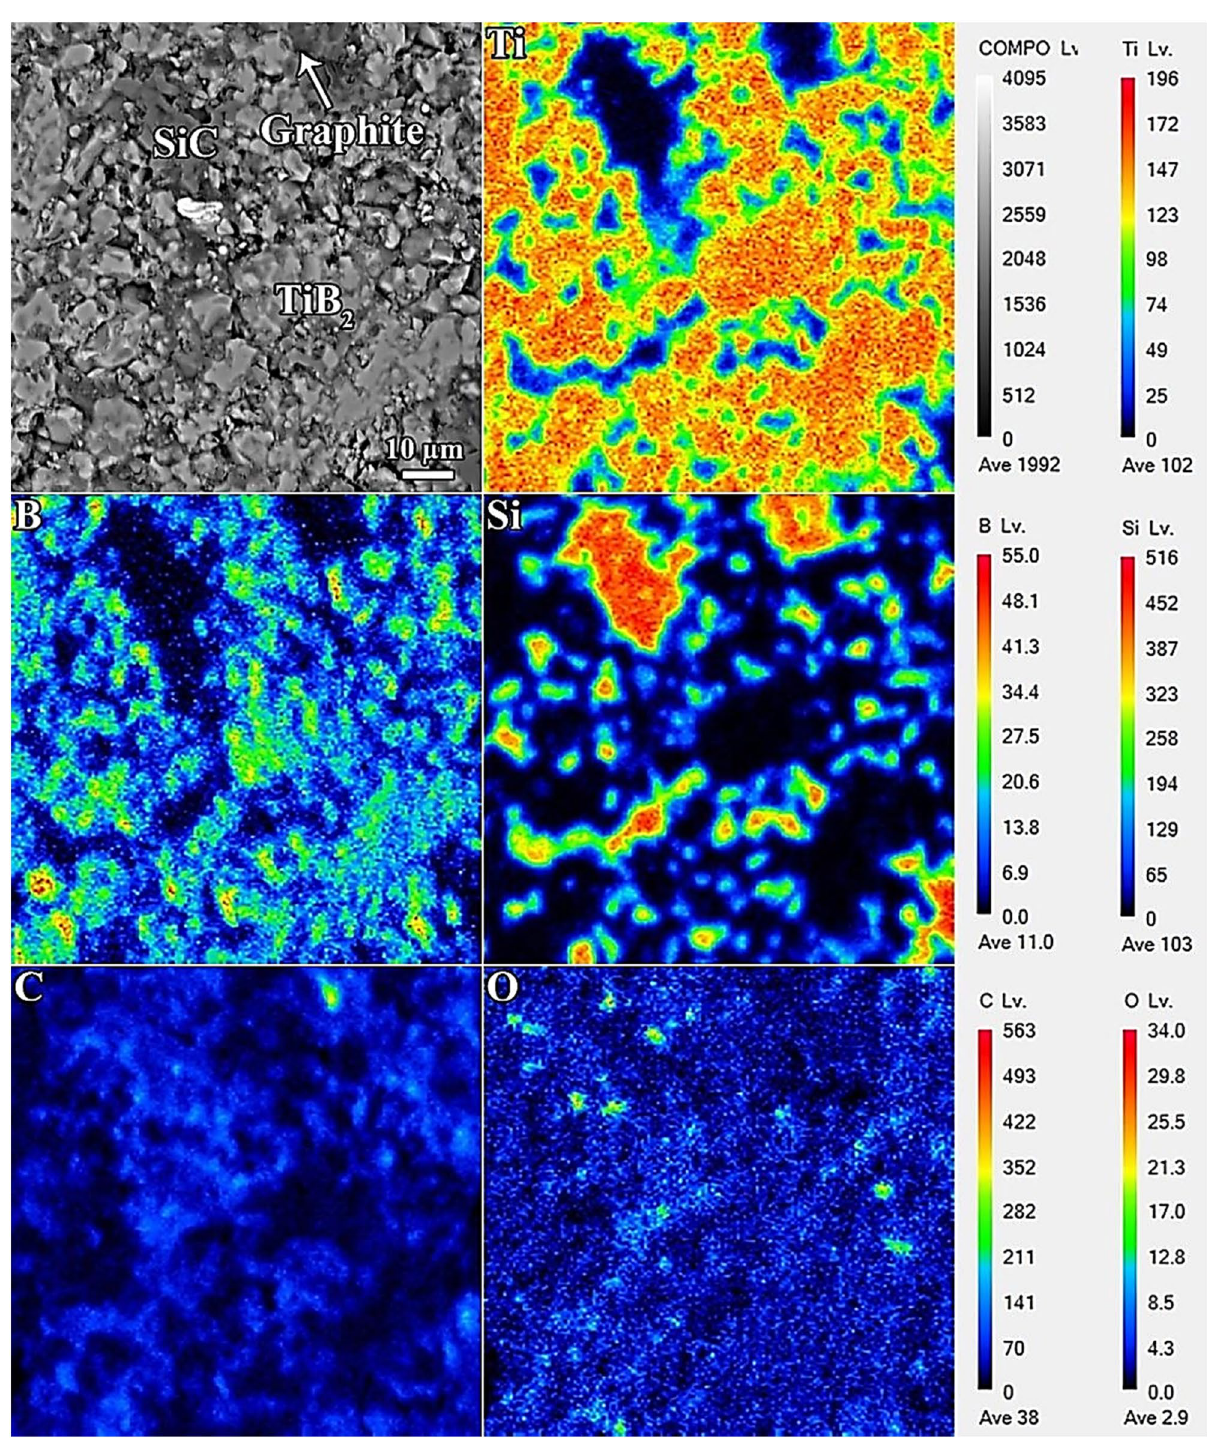
Figure 4. FESEM image of the fracture surface of C f -incorporated TiB 2 –SiC composite, and the relevant FEEPMA elemental mapping of Ti, B, Si, C, and O (indicated by three white arrows). Such a boundary was formed because of the vacancy concentration. Vacan- cies are typically formed by atomic diffusion. However, in the SPSed specimens, empty atomic positions can be formed because of the evaporation of the surface atoms between two adjacent particles in the initial step of the SPS during plasma formation at high temperatures 62 . The interfacial areas of TiB 2 and oxygen-rich compounds are presented in Fig. 9. The TiB 2 phase represents the (0 0 2) crystalline plane with a d-spacing of ~ 1.5 Å. The boundary non-uniformity line on the TiB 2 side can be observed in the HRTEM image, which implies atomic diffusion. In contrast, the interfacial area in the oxide